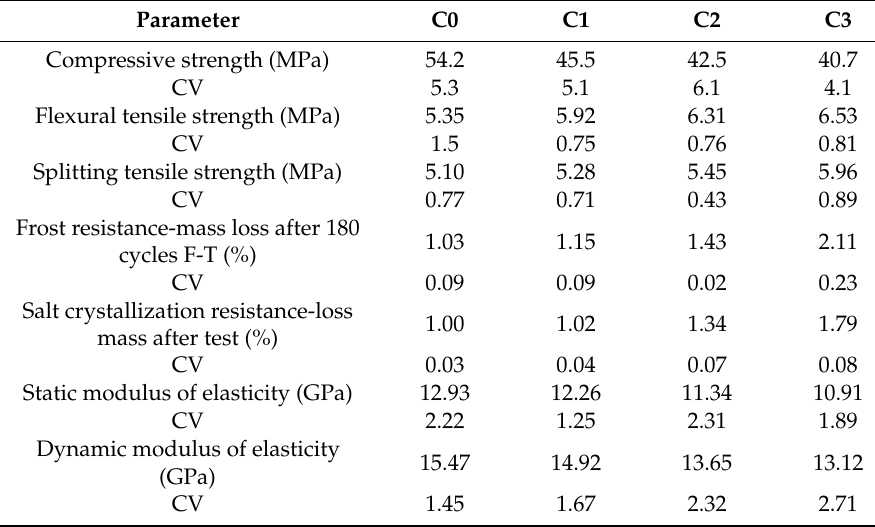
Table 5. Mechanical properties of the concretes.